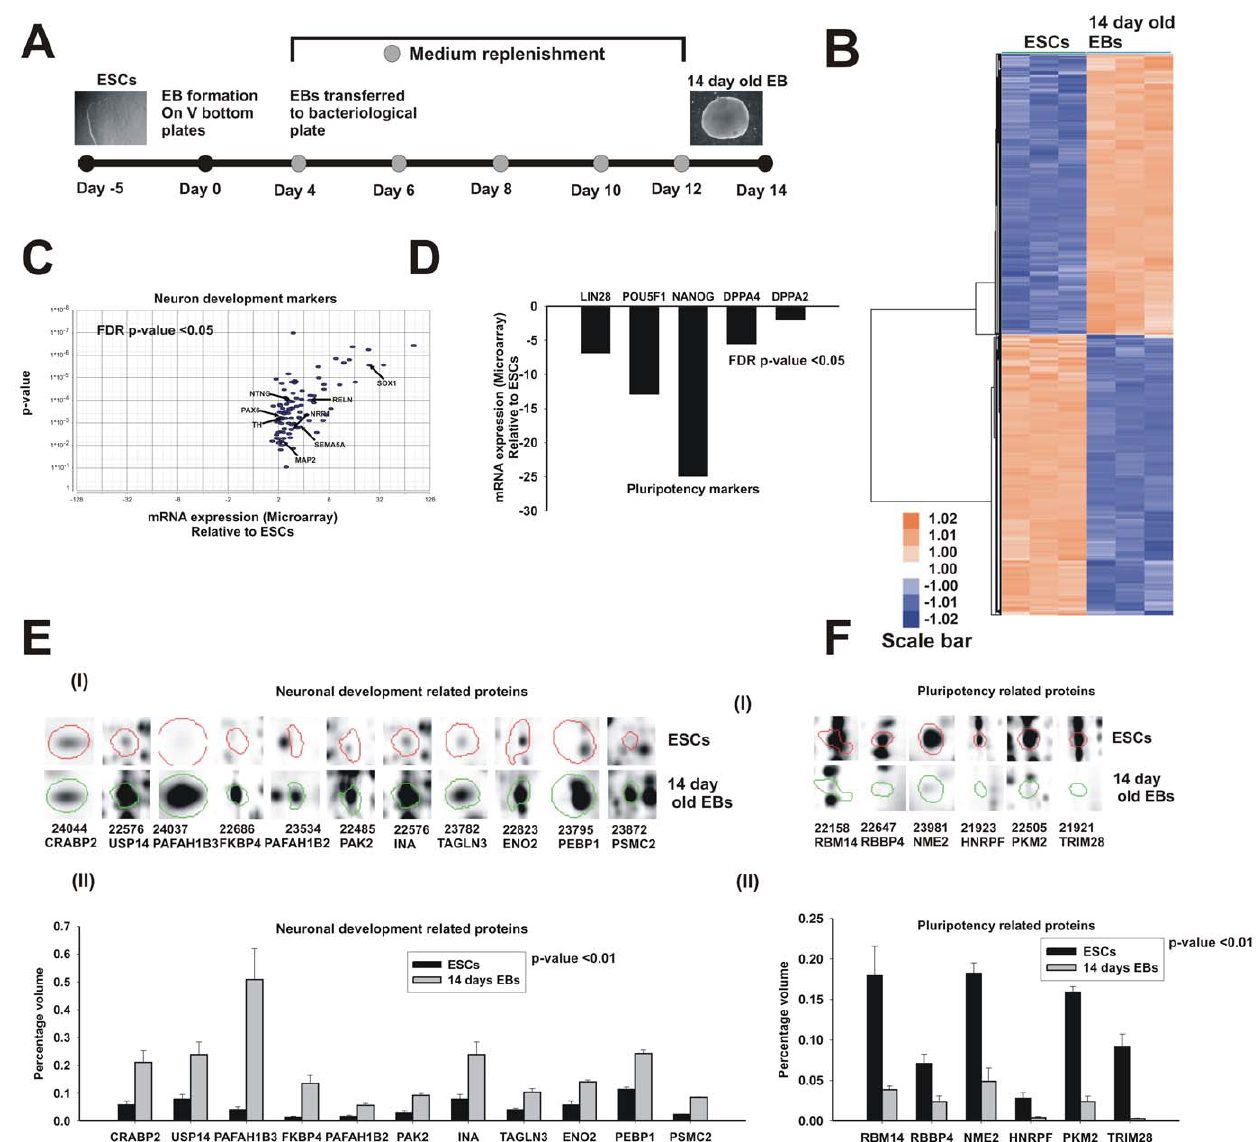
Figure 2. Enrichment of embryonic development associated genes in 14 days of hESC differentiation. A , A schematic representation of the 14 days hESC differentiation. B , An unsupervised hierarchical clustering analysis of DEG in hESC differentiation showed two distinct clusters for up and down-regulated genes. C , The over expressed neuron development BP (from Table S4) encompasses 86 genes and their gene expression pattern showed in volcano plot. In x-axis represents fold change and y-axis showed FDR-controlled p-values (p # 0.05). D , The pluripotency markers were significantly downregulated (as shown by microarray) after 14 days of differentiation. E , The mass spectrometry analysis of regulated proteins unravelled the up-regulated spots for neuronal development related proteins and ( F ) the down-regulated spots for pluripotency regulators. The differentially regulated proteins (n=3), (p # 0.01) are shown with their corresponding spot ID and UniProt ID (E (I), F (I)). Their expression patterns are represented as a percentage of volume (E (II), F (II)). The error bar represents SEM from 3 independent biological replicates.